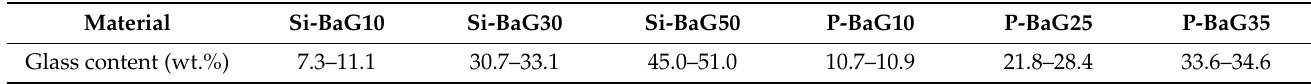
Table 3. The glass contents of the as-processed composites.